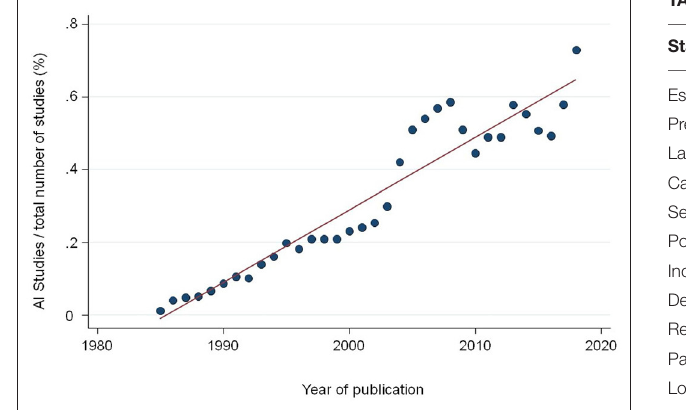
TABLE 1 | Dictionary of terms used in the statistical vs. machine learning/AI